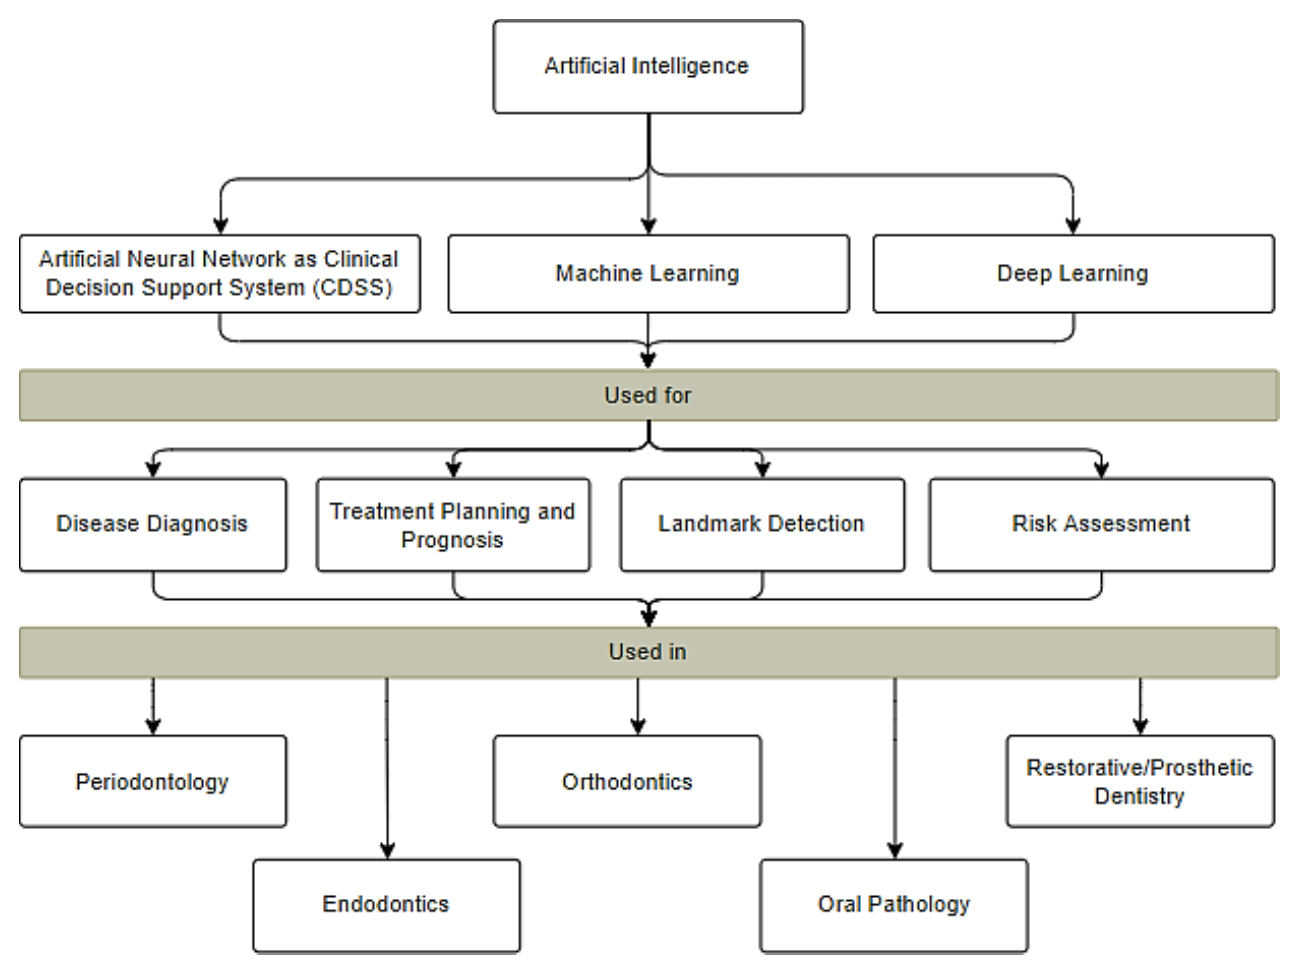
Figure 2. Applications of AI in different subfields of